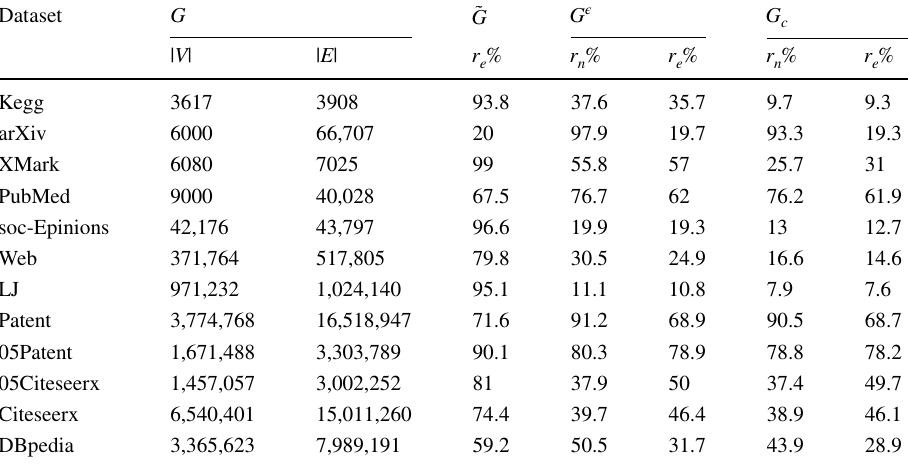
Table 1 Real-world datasets and their compression ratio after DAG reduction and multilevel compression